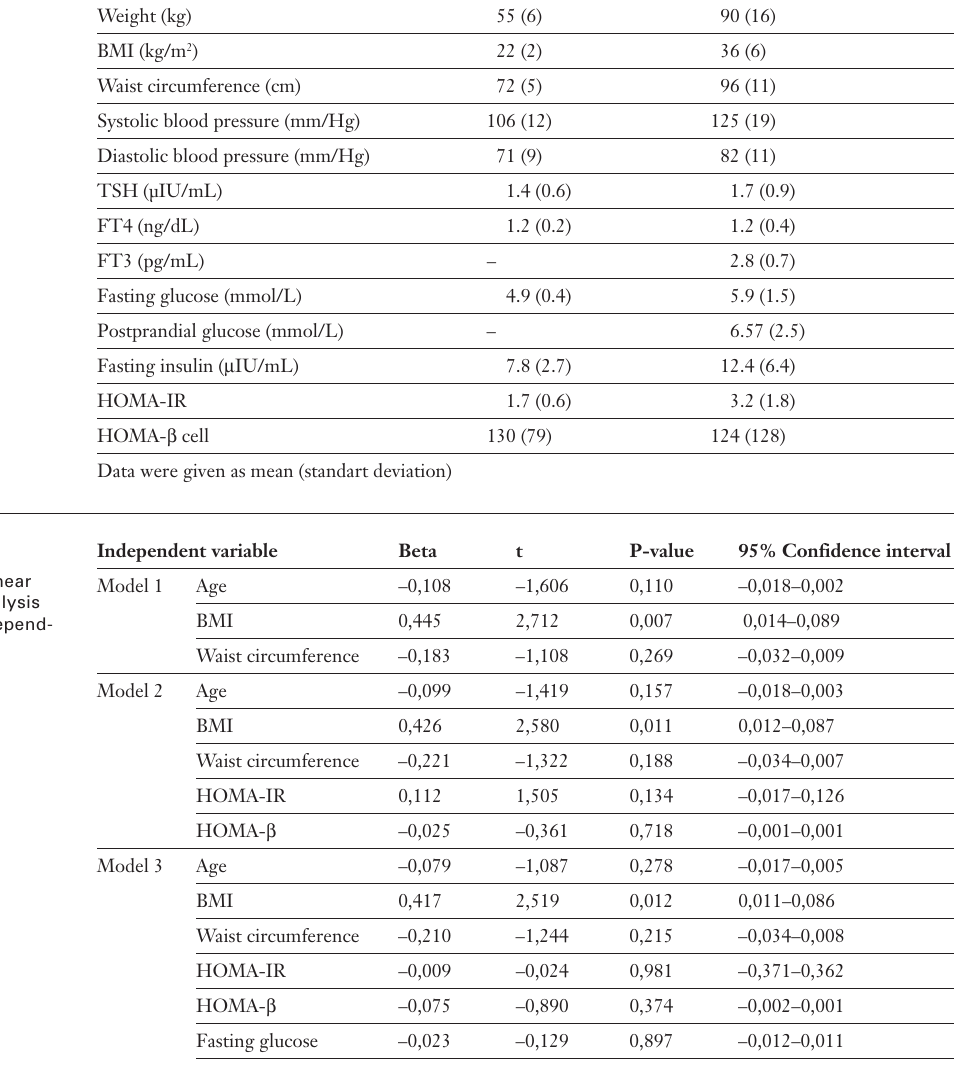
Anthropometric and clinical characteris- tics of lean and obese subjects.